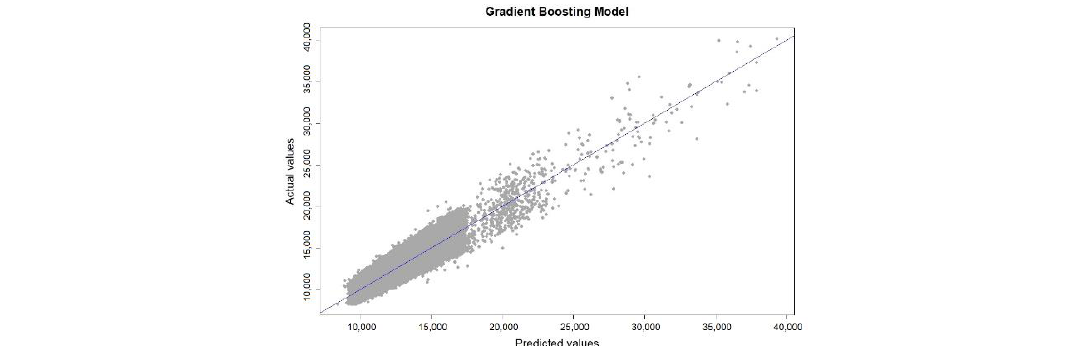
Figure 6. Comparison of predictions and actual values with the CART, RF, and GBM models.